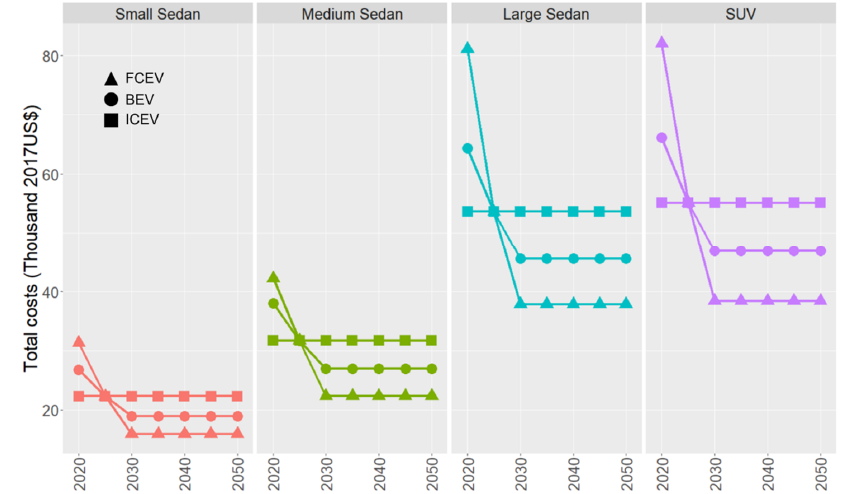
Figure 6. Assumption of total costs (see Supplementary Materials).